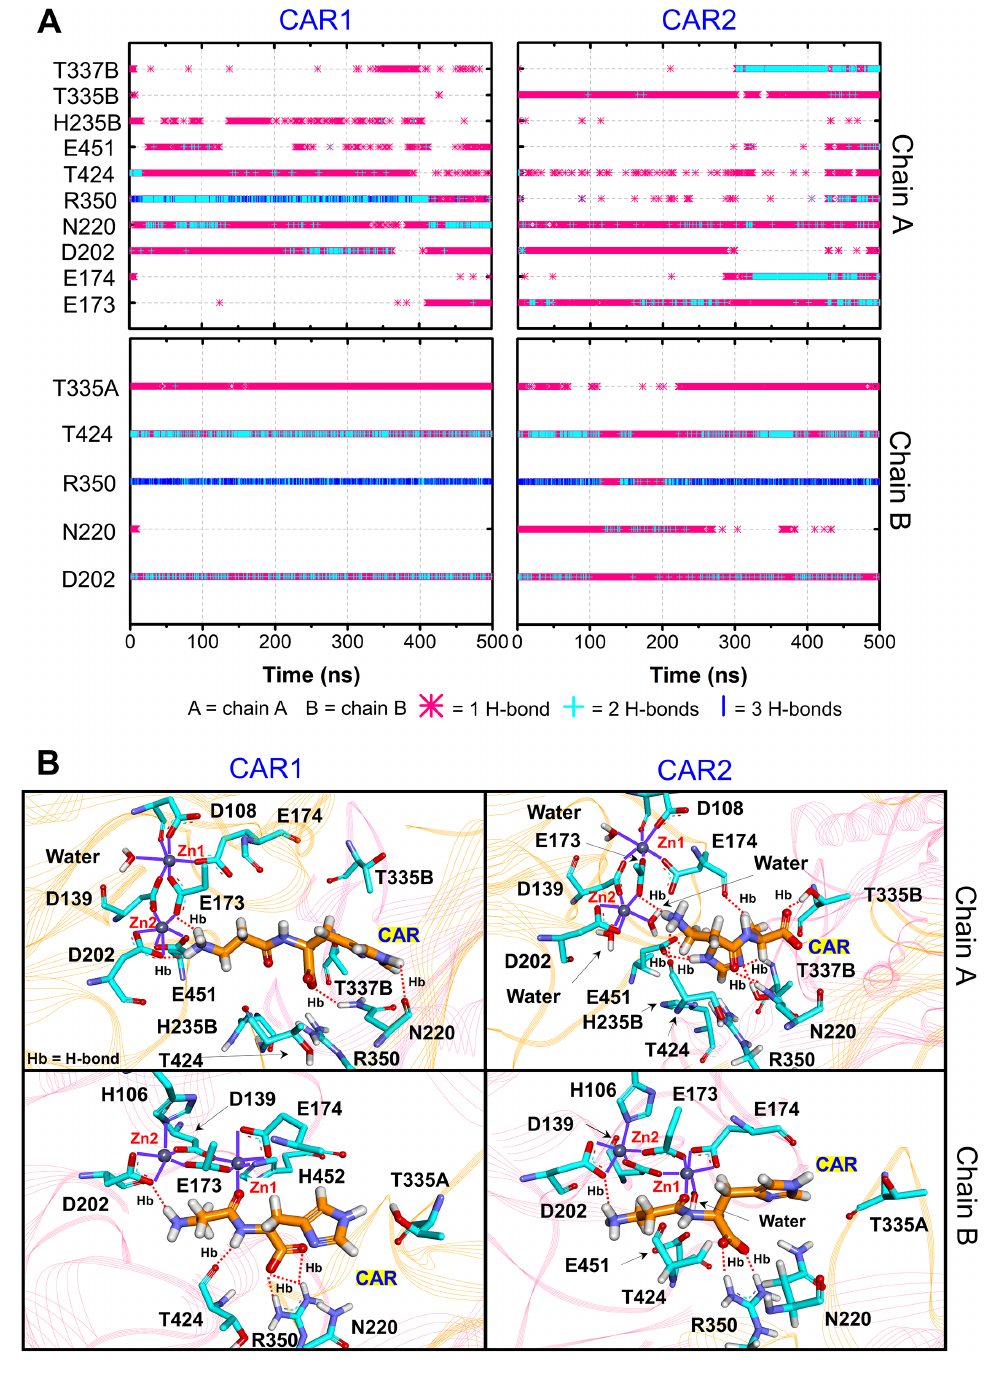
Figure 5 CN1-CAR interactions. (A) Hydrogen bonds between carnosine in both repeats (CAR1 and CAR2) and key residues. The locations of key components are displayed in (B). The purple lines show residues and waters that are within 3 Å of dizinc ions. The red dashed lines indicate the hydrogen bonds